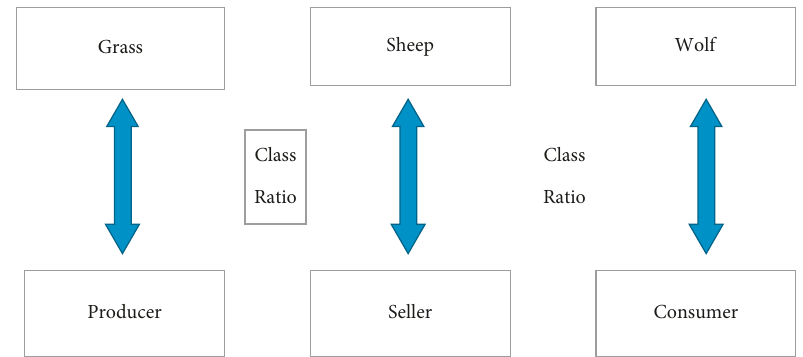
Figure 7: Working relationship among each node of agricultural product supply chain.